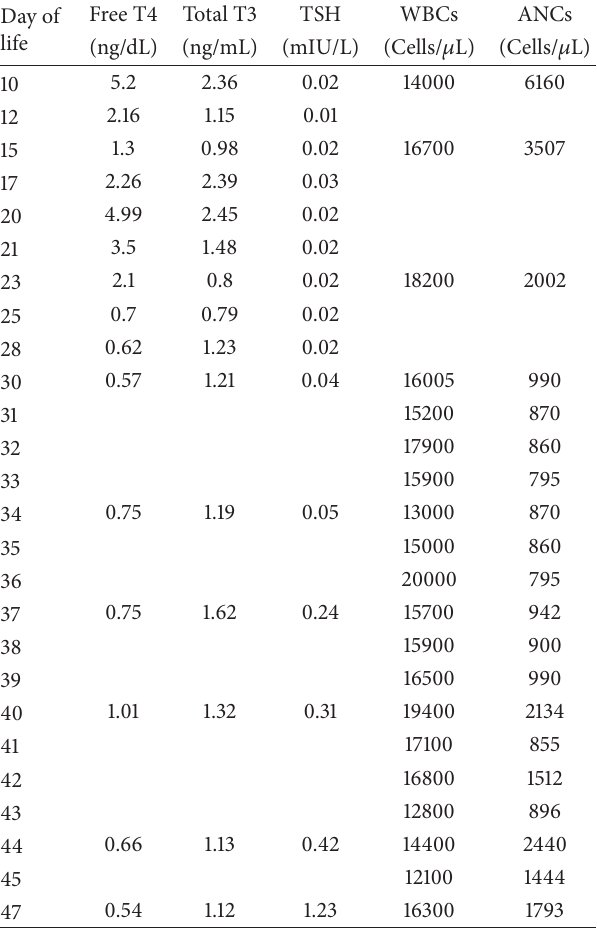
Table 1: Free T4, total T3, and TSH levels as well as white blood cell count and absolute neutrophil counts during hospitalization at our institution. Normal values for FT4: 0.75–1.54 (ng/dL), T3: 0.9–2.6 (ng/mL), and TSH: 0.5–6.5